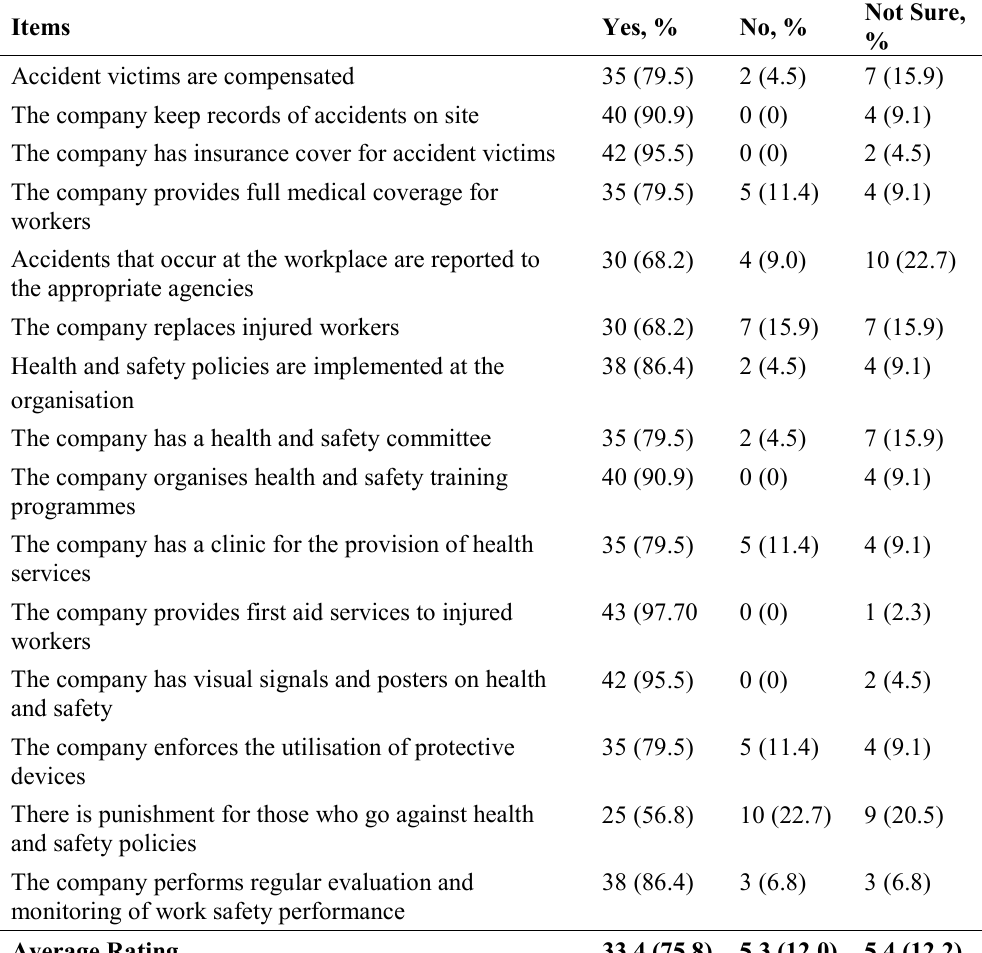
Table 1. Company’s Health and Safety